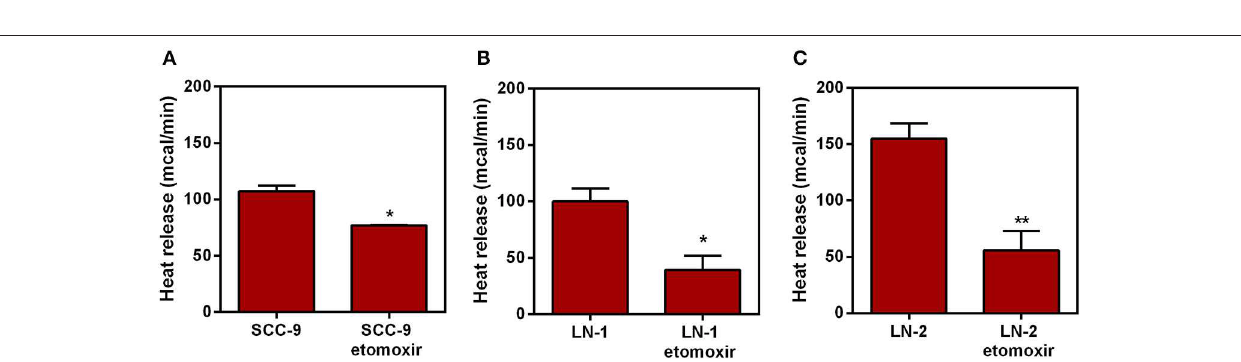
FIGURE 8 | Effect of etomoxir on the heat release by human oral squamous carcinoma cells SCC-9, LN-1 and LN-2 cells. The bars represent the release of total heat of living cells in 35min of experiment. (A) Heat release by SCC-9 cells untreated and treated with 300 µ M of etomoxir; (B) Heat release by LN-1 cells untreated and treated with 300 µ M of etomoxir. (C) Heat release by LN-2 cells untreated and treated with 300 µ M of etomoxir. Values were expressed as mean ± SEM. * p < 0.05; ** p <